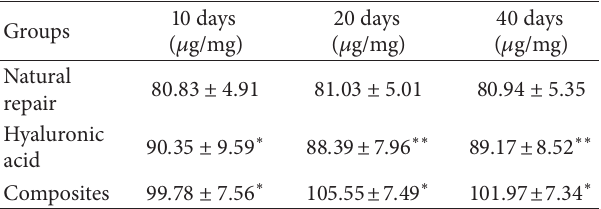
Table 1: The content of type II collagen in the repair area at different time points ( 𝜇